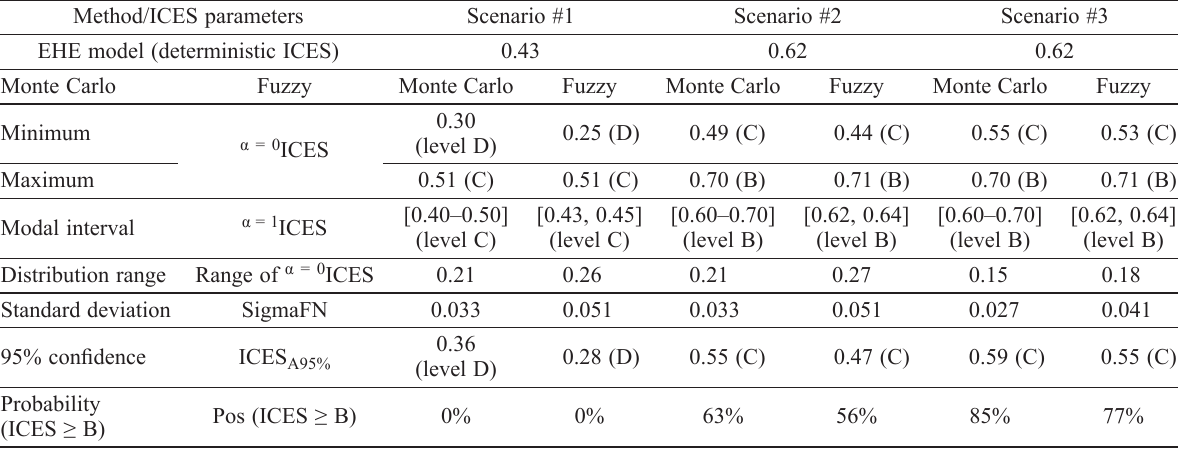
Table 3. Case study: results and comparison with the deterministic and simulation